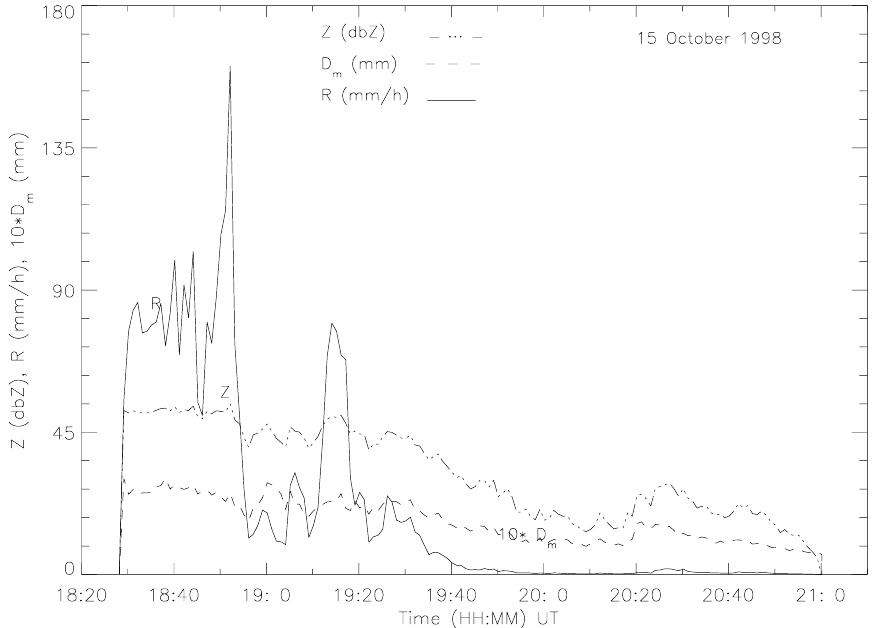
Fig. 2. Time evolution of rainfall rate, R, and mass weighted mean diameter, D m , and reflectivity, on 15 October 1998 between 18:20 and 21:00 UT.